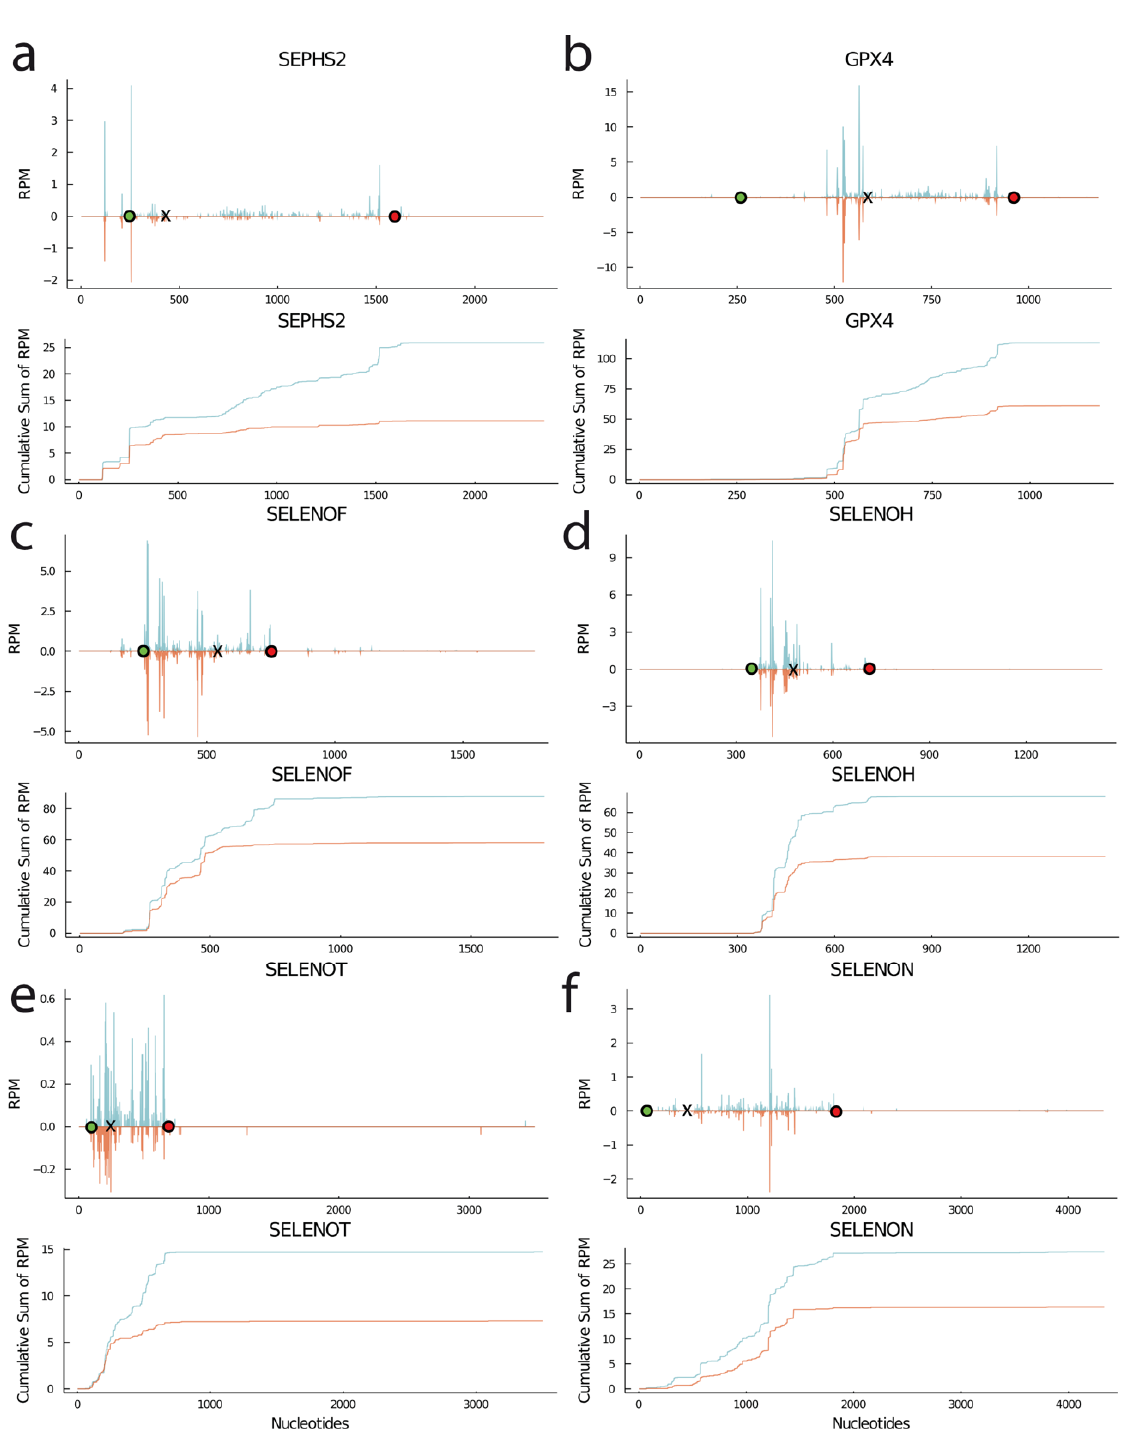
Figure 3. Ribosomal profiling in SECISBP2 -mutant HAP1 cells. ( a ) SEPHS2 ( b ) GPX4 ( c ) SELENOF ( d ) SELENOH ( e ) SELENOT ( f ) SELENON. RPM reads per million mapped reads. The mean values of the genotypes were plotted. The position of the UGA/Sec codon is marked by “ × ”. Start and Stop positions are marked as green and red circles. Cumulative sums of RPF are shown below the corresponding profiles. Ctl, blue; SECISBP2 -mutant, orange.